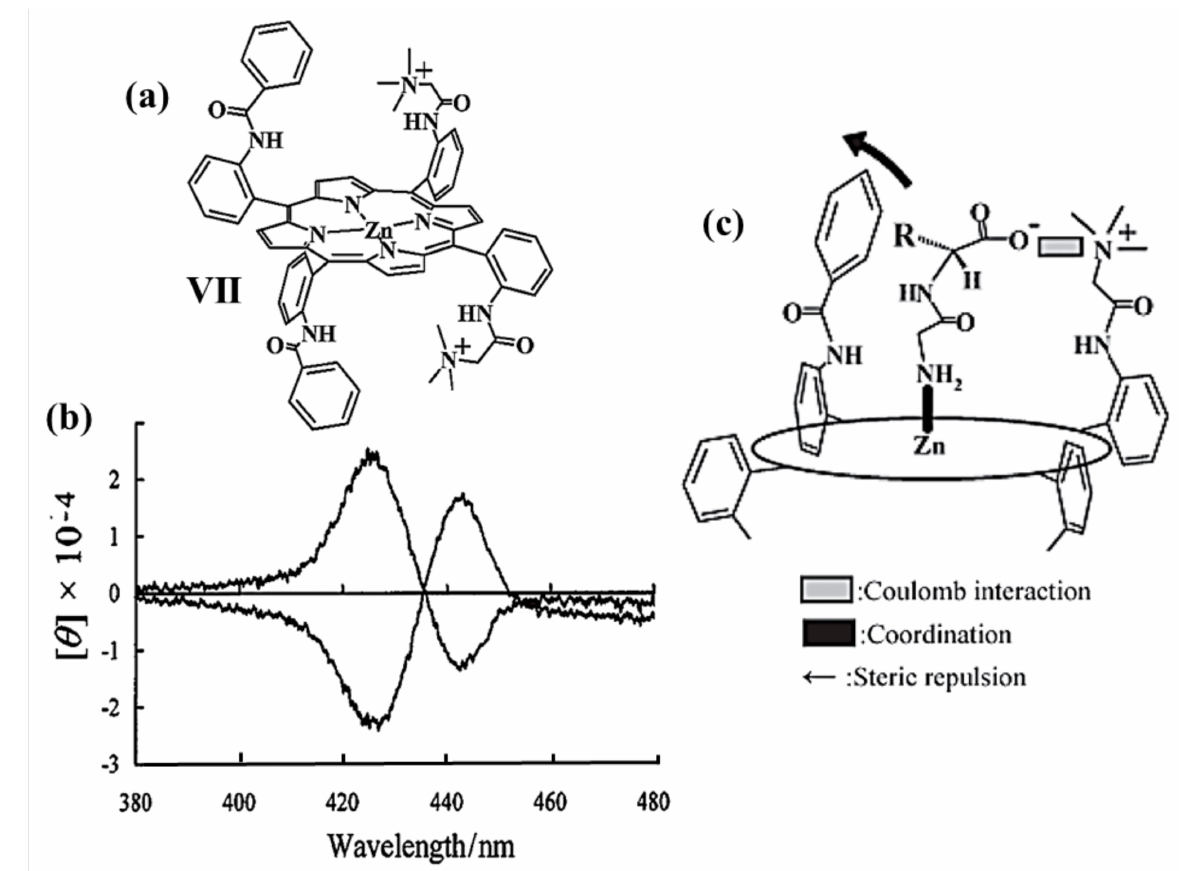
Figure 4. ( a ) Structure of chiral Zn(II)-porphyrin derivative VII ; ( b ) CD spectra of separated enantiomers of chiral porphyrin VII in water (pH = 10.4, ionic strength = 0.02); ( c ) Proposed chiral recognition mechanism: molecular interactions between an enantiomer of chiral Zn(II)-porphyrin VII with D-amino acids. Adapted with permission from reference [62]; published by American Chemical Society